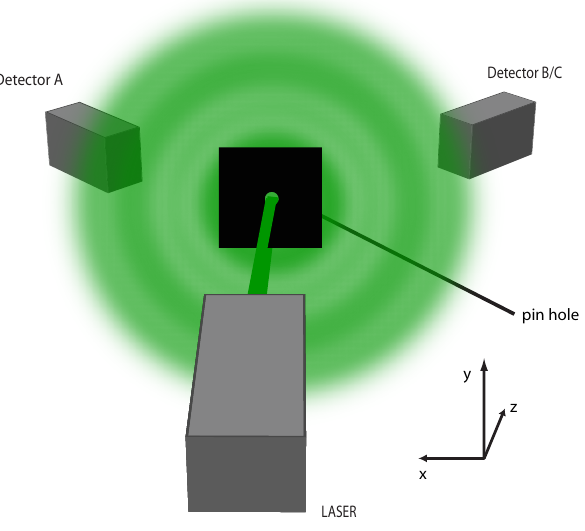
Fig. 5. The experimental setup for the measuring of the sensitive volume. The diffraction on the pinhole simulates the scattering on a particle. The pinhole can be displaced precisely along the x-, y- or z-axis.